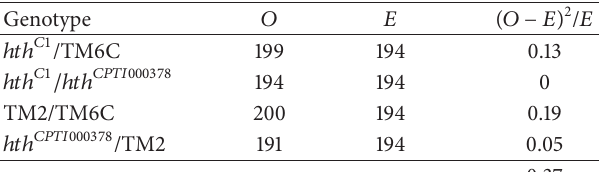
Table 3: Chi-square test was performed to check whether the observed numbers ( 𝑂 ) match with the expected numbers ( 𝐸 ). The results suggest that the observed numbers are in line with the expected Mendelian ratio. The degrees of freedom (df) are 3 and the probability 𝑃 ( 𝑋 2 ≥ 0.37 ) = 0.9463 on 3 degrees of freedom. This indicates that the difference between the observed data with expected values is not significant. In other words, the number of flies that we observed in each genotype category is in line with what would be expected based on Mendelian